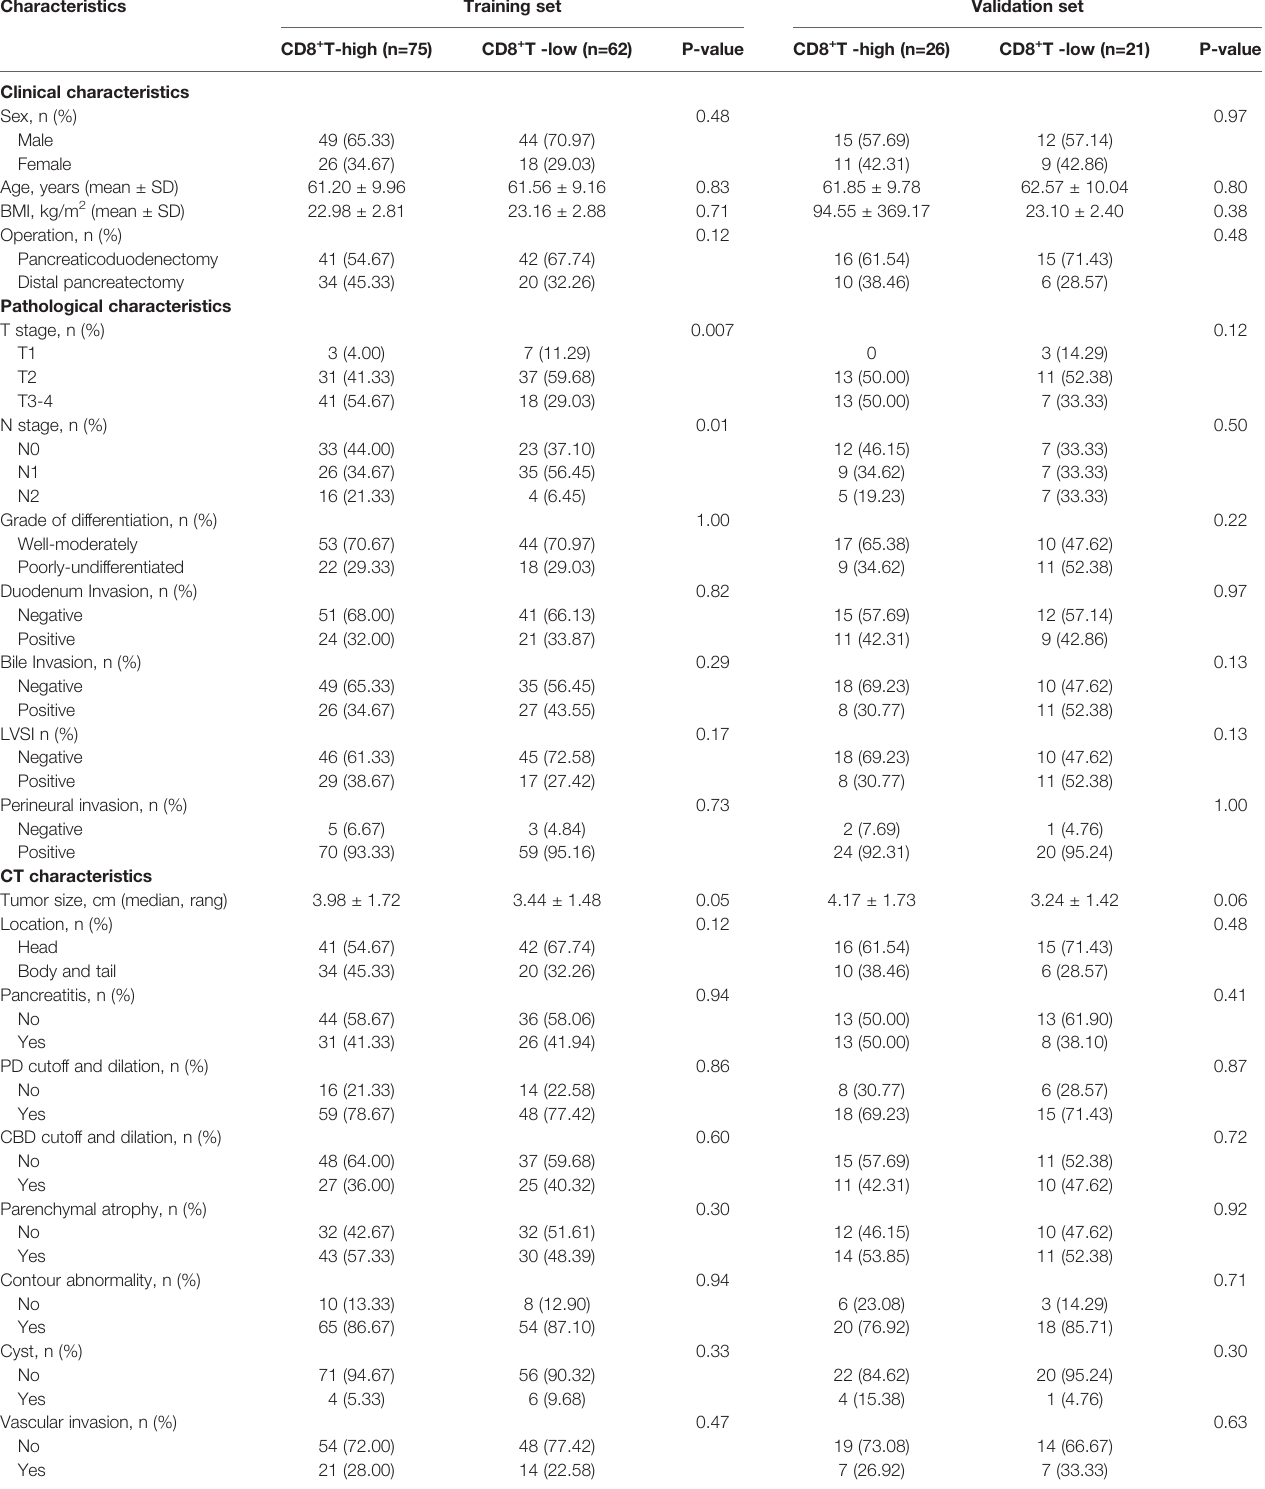
TABLE 1 | Baseline characteristics of patients with pancreatic cancer. Characteristics